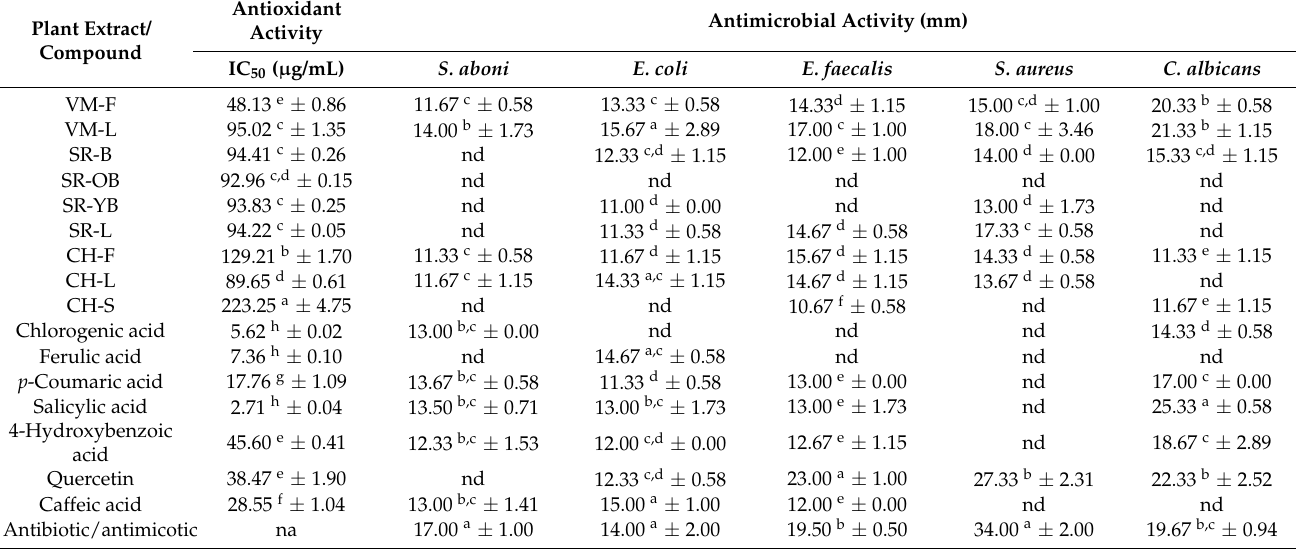
Table 2. Bioactive properties of the investigated plant